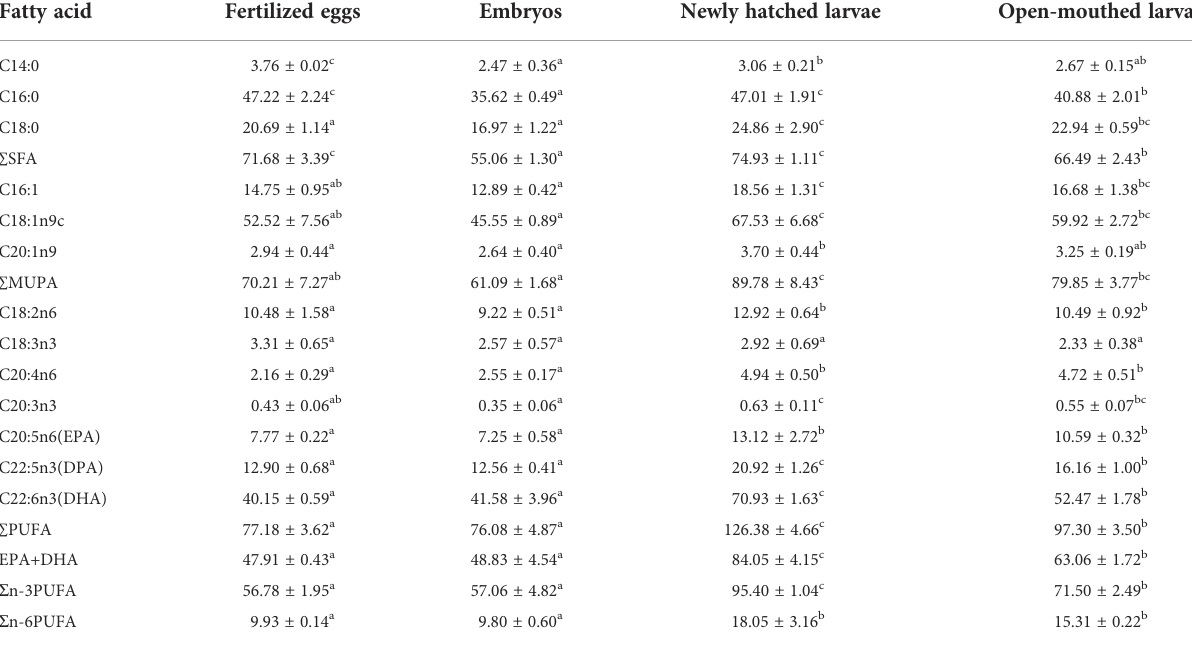
TABLE 5 The actual content of the main fatty acid of cobia in different development stages n=3, mg/g dry